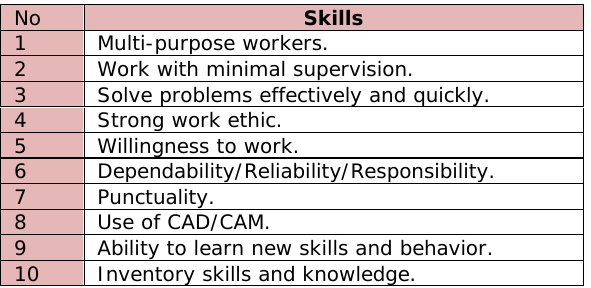
Table 2. “Top Ten Important Skills most demanded for the private sector of labor market in Kuwait